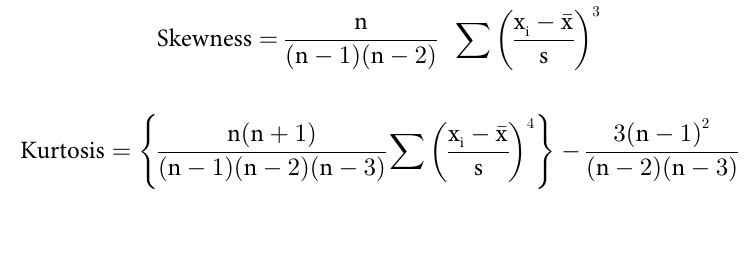
data distribution, while the kurtosis measures the tailedness of this distribution, providing an indication of the presence of outliers. The closer to zero values the skewness and kurtosis are, the more normal is the distribution of data. Both skewness and kurtosis were calculated via the formulas available on Excel based on Fisher’s